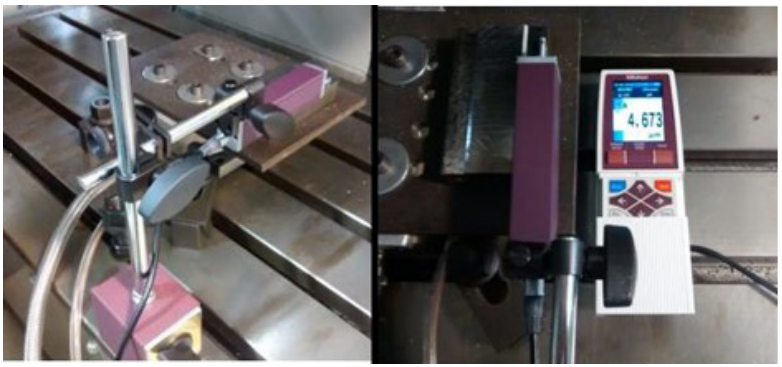
Fig. 4. Roughness method of analysis used after